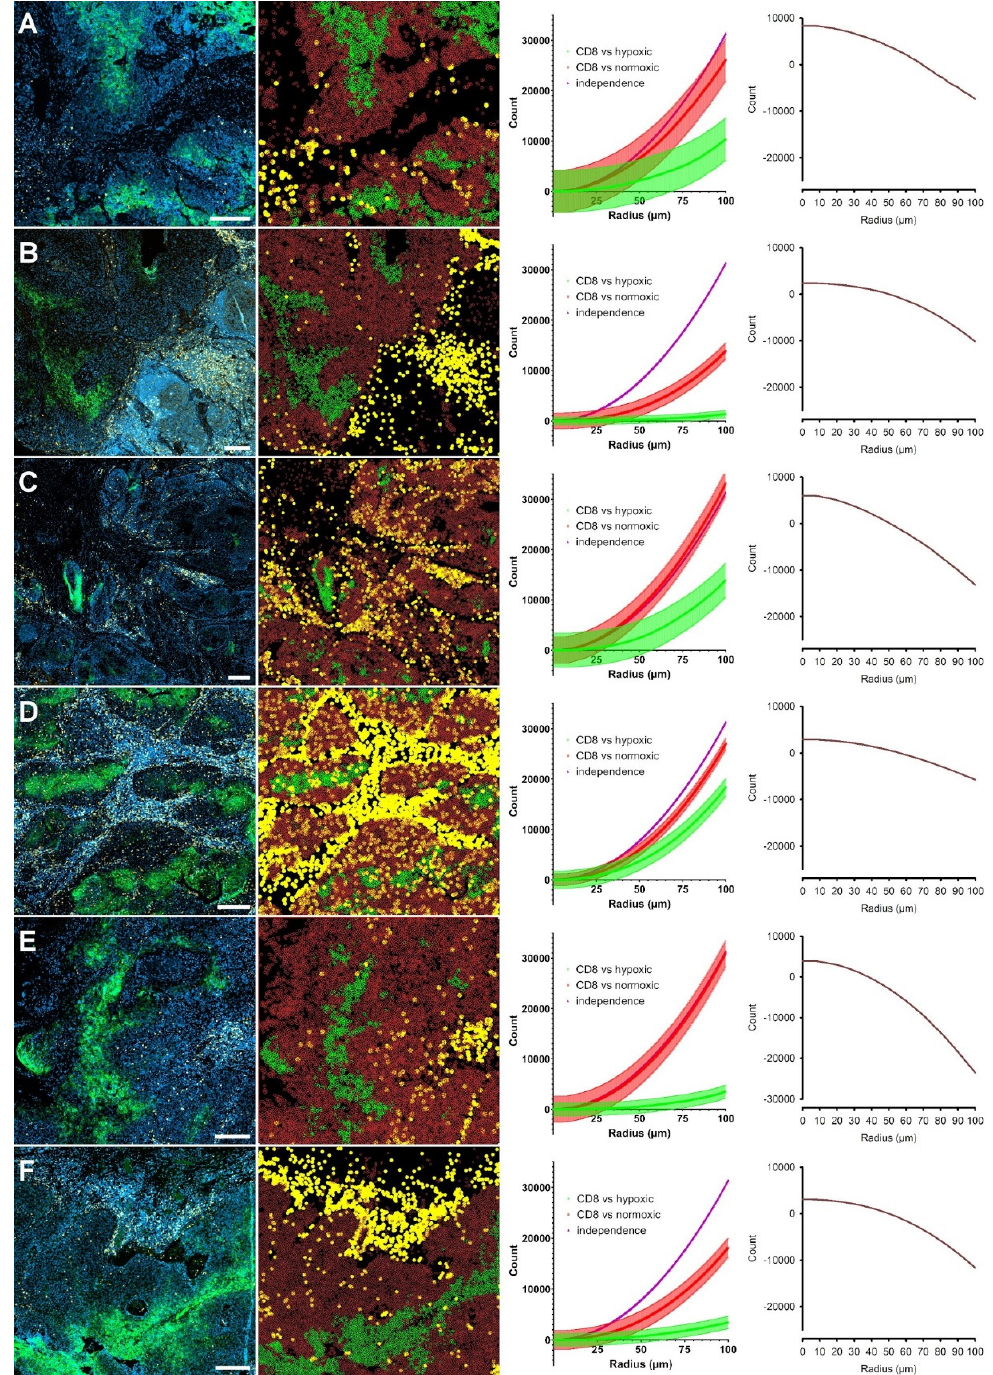
Figure 4. Demonstration of the repellent effect of hypoxic tissue areas on CTL infiltration. Six examples ( A – F ) showing significantly stronger inhibitory effects of hypoxic tumor cells compared to normoxic tumor cells concerning the distribution of CTL. Each row corresponds to one tumor. Left panels : original immunofluorescence images (DAPI, blue; hypoxic cells, green; CTL, yellow), all scale bars: 200 µ m. Left middle panels , corresponding Spatstat point pattern representation of the different groups of cells identified in the tumor sections (hypoxic tumor cells, green; normoxic tumor cells, dark red; CTL, yellow). Right middle panels , inhomogeneity-corrected Kcross functions testing the distribution of CTL vs. hypoxic (green) and normoxic (red) tumor cells. The areas